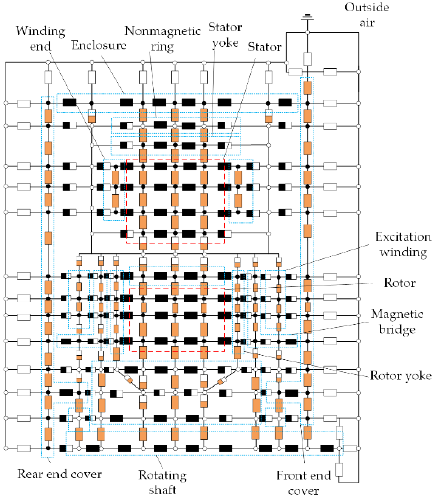
Figure 7. Schematic diagram of 3D thermal network in steady state.